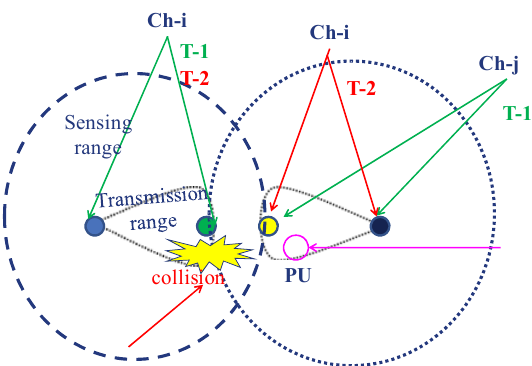
Figure 1. Multi-channel hidden terminal with sequential CCC based CR-MAC protocol.